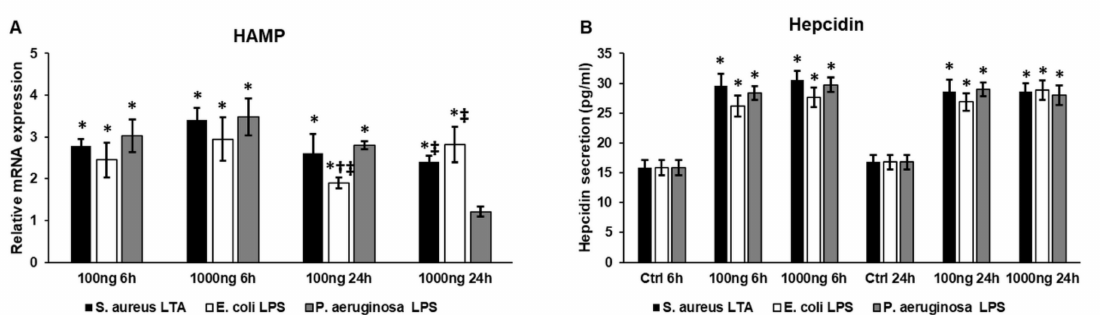
Figure 3. Real-time PCR and ELISA measurements of hepcidin expression in lipopolysaccharide (LPS)- and lipoteichoic acid (LTA)-treated THP-1 cells. Real-time PCR was performed with SYBR Green protocol. β -actin was used as internal control for the normalization. The relative expression of untreated controls was regarded as 1. The mRNA expressions of the treated cells were compared to their appropriate controls (6 h and 24 h). Secreted hepcidin concentrations of the culture media were determined with a human hepcidin ELISA kit according to the instructions of the manufacturer. ( A ) mRNA expression levels of HAMP of THP-1 cells treated with LTA and LPS isolated from different sources. ( B ) Secreted hepcidin concentration of THP-1 cells treated with S. aureus LTA, E. coli LPS and P. aeruginosa LPS. The columns represent mean values and error bars represent standard deviation (SD) of three independent determinations ( n = 3). Real-time PCR determinations and ELISA measurements were carried out in triplicate in each independent experiment. An asterisk * marks p < 0.05 compared to the controls. A cross † indicates p < 0.05 compared to LTA treatment and a double cross ‡ shows p < 0.05 compared to P. aeruginosa LPS